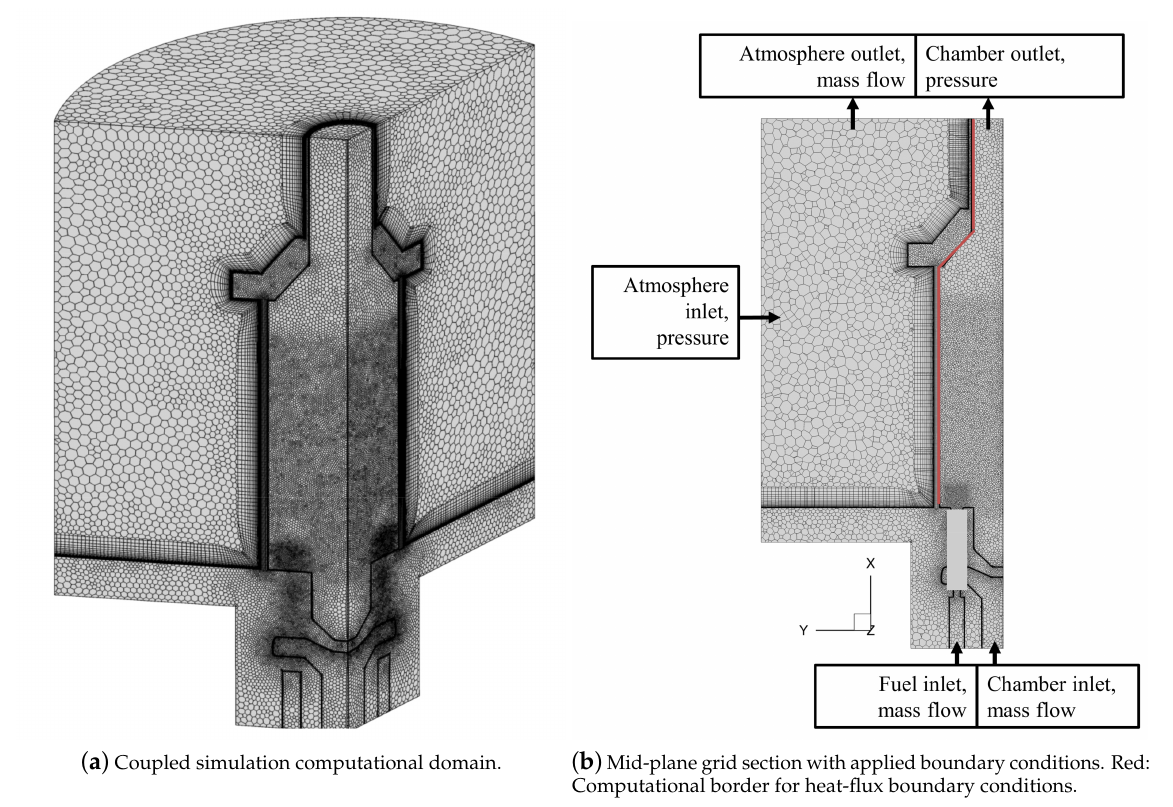
Figure 5. Numerical setup and computational